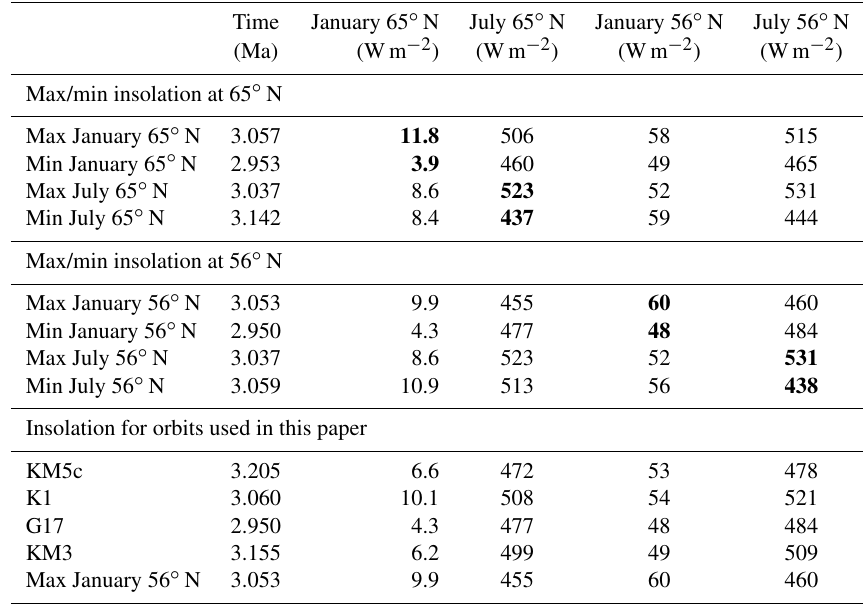
Table 2. TOA insolation at various times in the mPWP. The TOA insolation for each orbit was obtained using Laskar et al. (2004). Values in bold highlight the maximum and minimum insolation in each